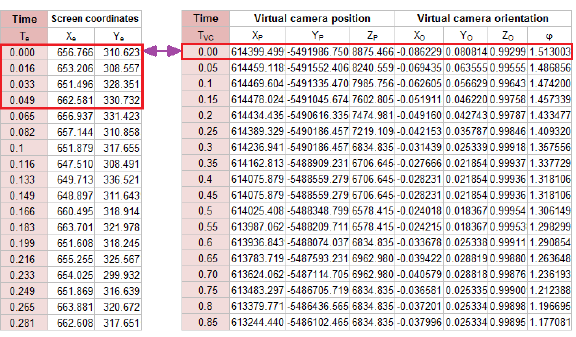
Fig. 2. Examples of data about eye-tracking data (left) and virtual camera movement (right) and schema of their